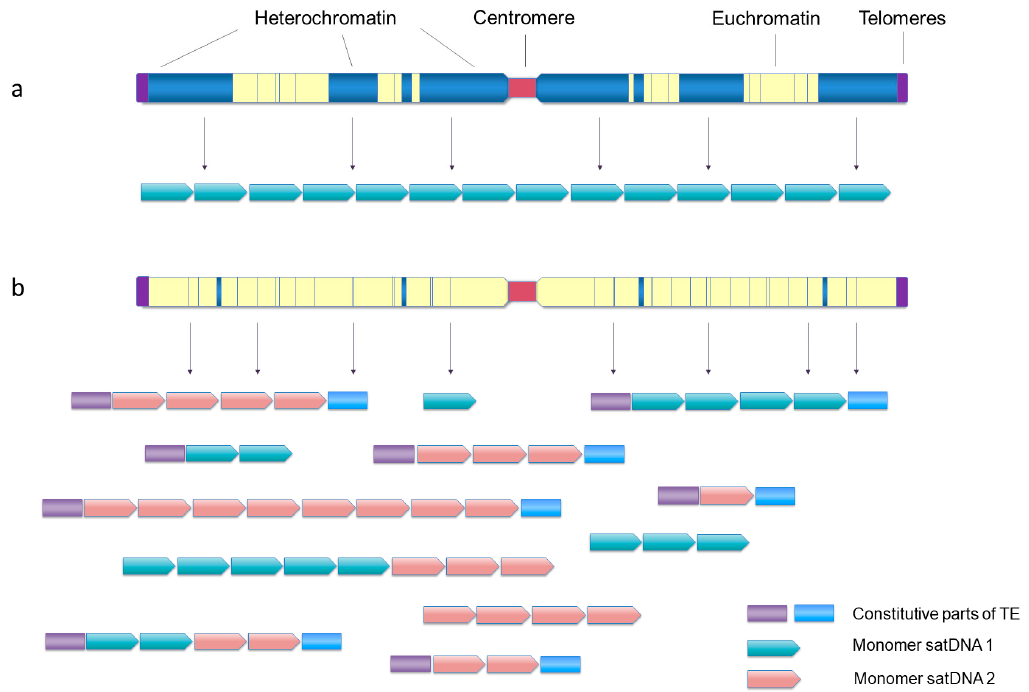
Figure 2. Two signi fi cantly di ff erent pa tt erns of satDNA organization at the genome level. ( a ) satDNAs occupying large pericentromeric, subtelomeric and interstitial blocks of heterochromatin, with sporadic short arrays or single monomers situated in the euchromatin. ( b ) satDNAs organized in short arrays, highly dispersed throughout the chromosomes without any signi fi cant clustering, frequently found associated with TEs or their parts or short arrays of other satDNAs.